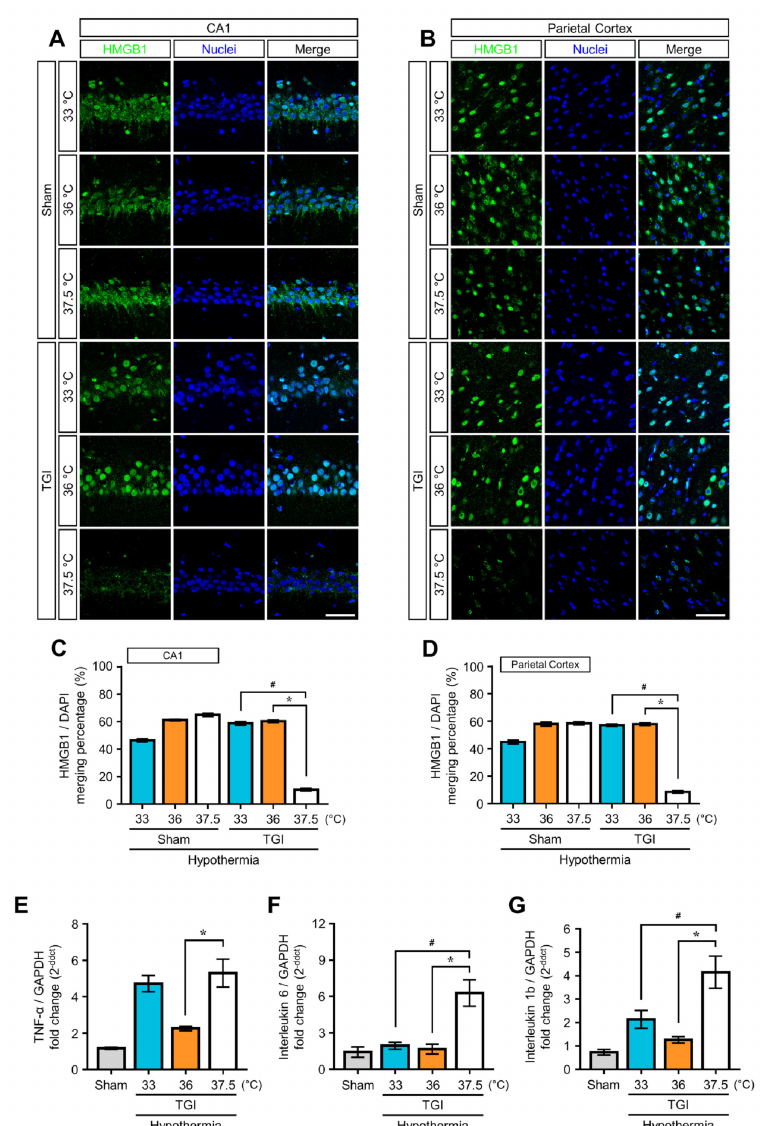
Figure 3. TTM blocks high mobility group box 1 (HMGB1) and cytokines release after TGI. HMGB1 level measured at 4 h after TGI. ( A , B ) Representative images showed co-localization of HMGB1 with nuclei (DAPI fluorescent stain). In the sham groups, HMGB1 expression was correlated with nuclei. TGI at normal temperature (37.5 ◦ C) accelerated HMGB1 release from the nuclei, and TGI-TTM at 33 ◦ C and 36 ◦ C prevented HMGB1 release in the hippocampal cornus ammonis 1 region. Scale bar = 50 µ m. ( C , D ) Percentage of HMGB1 and nuclei (DAPI) correlation in both hippocampal cornus ammonis 1 and parietal cortex in both hypothermic paradigms (one way- ANOVA, multiple comparison following Bonferroni adjustment. Sham + 33 ◦ C, n = 4; Sham + 36 ◦ C, n = 4; Sham + 37.5 ◦ C, n = 4; TGI + 33 ◦ C, n = 4; TGI + 36 ◦ C, n = 4; TGI + 37.5, n = 4. * p and # p < 0.05). HMGB1 release from nuclei triggered pro-inflammatory cytokine expression. ( E – G ) Quantification of fold change (2 − ddct value) by quantitative polymerase chain reaction of tumor necrosis factor-alpha, interleukin-1 β , and interleukin-6 versus glyceraldehyde 3-phosphate dehydrogenase. The expression of tumor necrosis factor-alpha, interleukin-1 β , and interleukin-6 was decreased after TTM at 33 ◦ C and 36 ◦ C compared to the expression at 37.5 ◦ C (normal temperature). TGI-TTM at 36 ◦ C decreased tumor necrosis factor-alpha expression significantly more than TGI at 37.5 ◦ C (one way-ANOVA, multiple comparison following Bonferroni adjustment. Sham, n = 3; TGI + 33 ◦ C, n = 3; TGI + 36 ◦ C, n = 3; TGI + 37.5, n = 3. * p and # p <